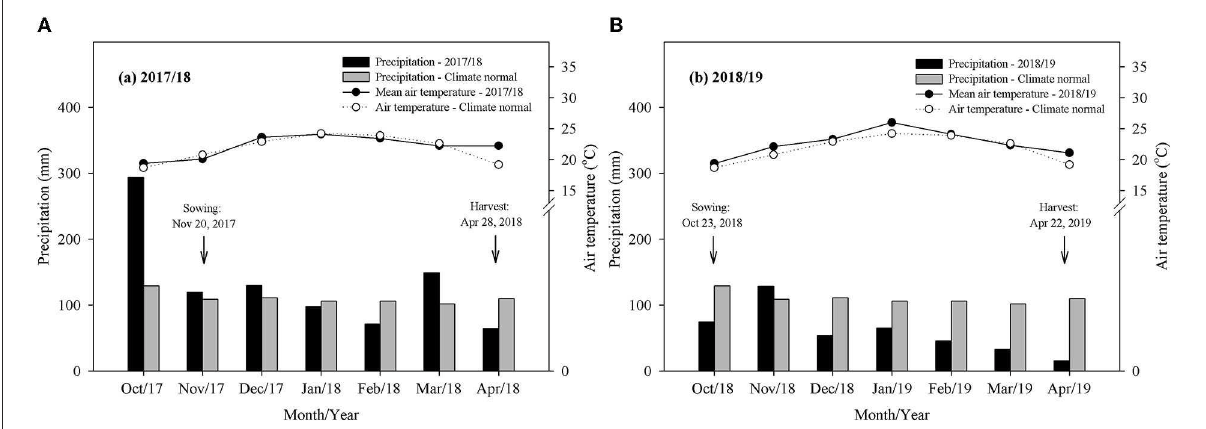
FIGURE1 Monthly precipitation and mean daily air temperature at the Agronomy Experimental Station from the Federal University of Rio Grande do Sul during the soybean growing seasons of 2017/2018 (A) and 2018/2019 (B) and climate normal (1970–2009).